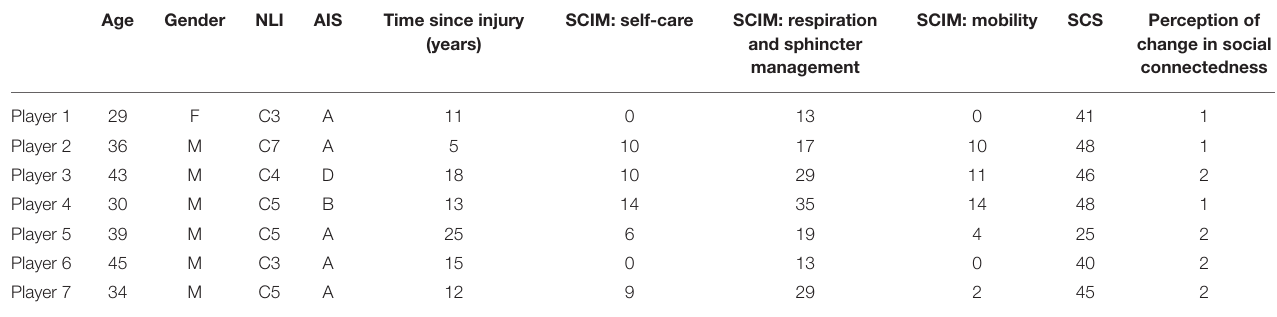
TABLE 2 | Player demographics, clinical details, and social connectedness